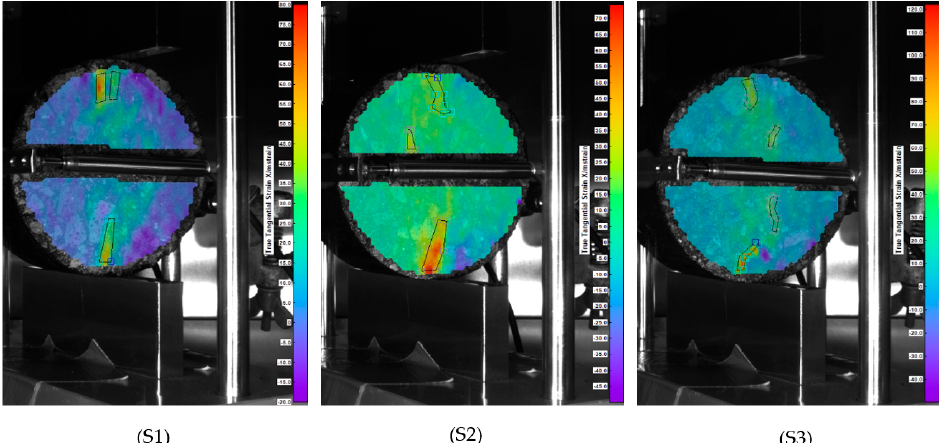
Figure 5. Horizontal strain map of the three samples at the termination cycle of the first step of the experiment calculated by Istra 4D, termination cycles: S1 = 6517, S2 = 2415, S3 = 3585.